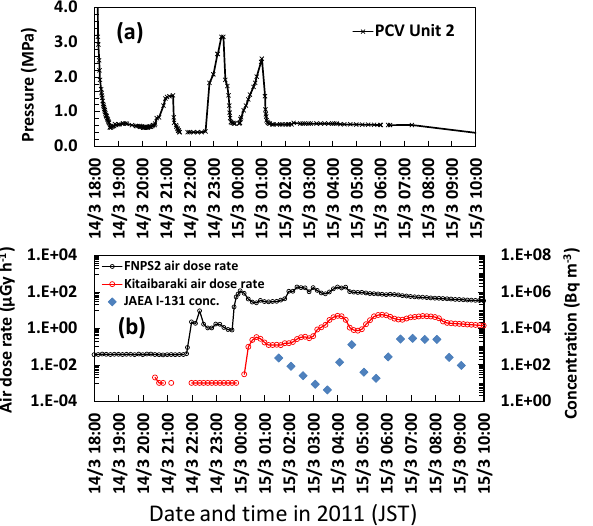
Figure 9. Temporal changes in measurements of (a) the pressures of the drywell (DW) at Units 2 and 3 of FNPS1, and (b) the air dose rates at several monitoring posts from 15 to 16 March 2011. The locations of the monitoring posts are depicted in Fig.